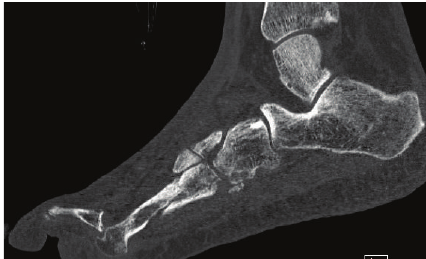
Figure 3: CT scan at the level of the left 4th toe illustrating fracture malunion and dorsal dislocation at the MTP joint.